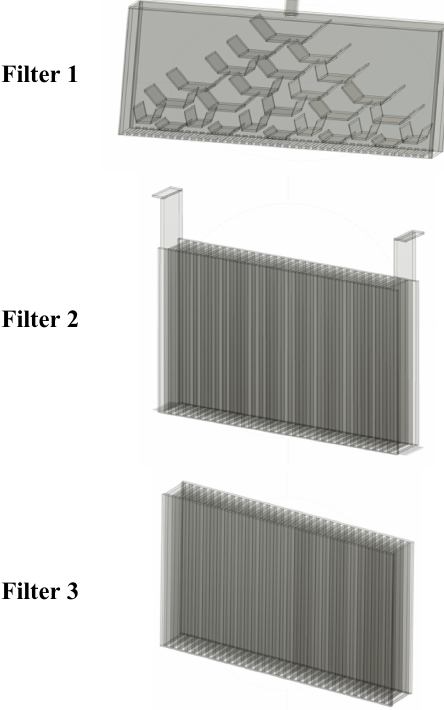
Figure 6. Custom template employed for precise distribution of particles within the model. ( a ) 3D printed template (top), and ( b ) template with hydrogel particles placed within it (bottom).